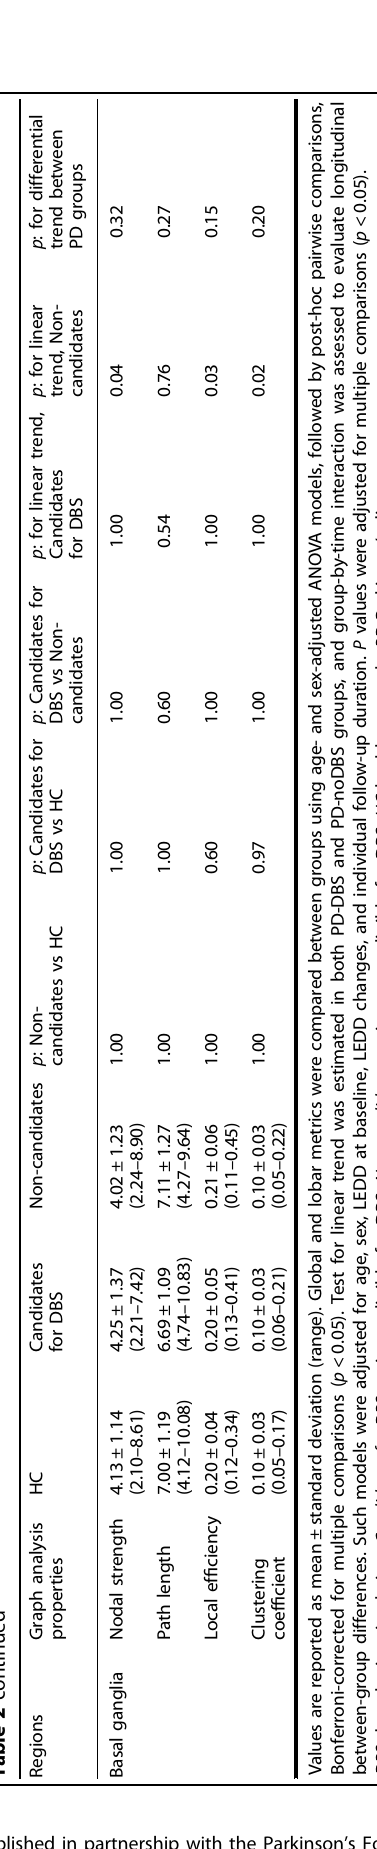
and compared using ANOVA models, a decreased connectivity between sensorimotor-basal ganglia, frontal-basal ganglia, and frontal-parietal regions and within the temporal network was found in candidates for DBS over time compared to controls ( p values ranging from 0.01 to 0.048, Bonferroni-corrected). Furthermore, patients eligible for DBS showed an increased functional connectivity relative to controls within the occipital network and between occipital-parietal regions (principal compo- nent) and within temporal networks and frontal insular-temporal regions (secondary components) ( p values ranging from 0.002 to 0.041, Bonferroni-corrected). Moreover, the non-candidate group revealed a widespread decreased functional connectivity com- pared to controls ( p values ranging from 0.001 to 0.047, Bonferroni-corrected). Patients candidate vs non-candidate for DBS . Global network analysis did not show differences between PD groups (Table 2). At the lobar network level, candidates for surgery showed a trend toward higher mean nodal strength and local ef fi ciency of the occipital areas relative to patients who were not eligible for DBS ( p = 0.06, Table 2 and Fig. 2a). Figure 2b reports the functional connectivity pattern that differs between the two PD groups in NBS analysis before permutation (uncorrected nonparametric test). The comparison did not reach global statistical signi fi cance after permutations. When the functional connectivity values of each connection were obtained from nonparametric test and compared using ANOVA models, increased connectivity within an occipital network and between occipital-parietal regions (principal component) was found in patients eligible compared to those not eligible for surgery (Supplementary Table 2, p values ranging from <0.001 to 0.04, Bonferroni-corrected). In addition, the group of candidates for DBS showed increased functional connectivity in the temporal, occipital-temporal, and frontal insular-temporal networks (sec- ondary components) relative to the other group of patients (Supplementary Table 2, p values ranging from <0.001 to 0.04, Bonferroni-corrected). On the contrary, a decreased connectivity between sensorimotor-basal ganglia and frontal insular-basal ganglia networks (principal and secondary components) was identi fi ed in patients eligible for DBS over time relative to those who were not eligible for surgery (Supplementary Table 2, p values ranging from <0.001 to 0.04, Bonferroni-corrected). Longitudinal functional brain network changes in Parkinson ’ s disease patients Longitudinal global and lobar network analysis results are summarized in Table 2. Candidates for DBS showed a progressive functional alteration of the global network properties over time. At the lobar level, a progressive decreased nodal strength, local ef fi ciency, clustering coef fi cient, and a longer path length were found in frontal insular and temporal regions in the group of patients eligible for DBS. Furthermore, they showed a progressive decreased nodal strength in the sensorimotor area and increased path length in occipital regions. In patients eligible for DBS, progressive increased nodal strength and local ef fi ciency were found in basal ganglia. When longitudinal global and lobar linear trends were compared between patient groups, candidates for DBS showed a progressive reduced nodal strength, local ef fi ciency, and clustering coef fi cient in the global network, frontal insular, temporal, and occipital regions relative to patients not eligible for surgery (Table 2). Moreover, a progressively increased path length was found in temporal and occipital regions in candidates for DBS relative to non-candidates. Functional connectivity changes over time were also compared between PD groups using NBS. Four distinct patterns of progression were identi fi ed: 9 (1) different trends of changes between groups (increase vs decrease, increase or decrease vs T